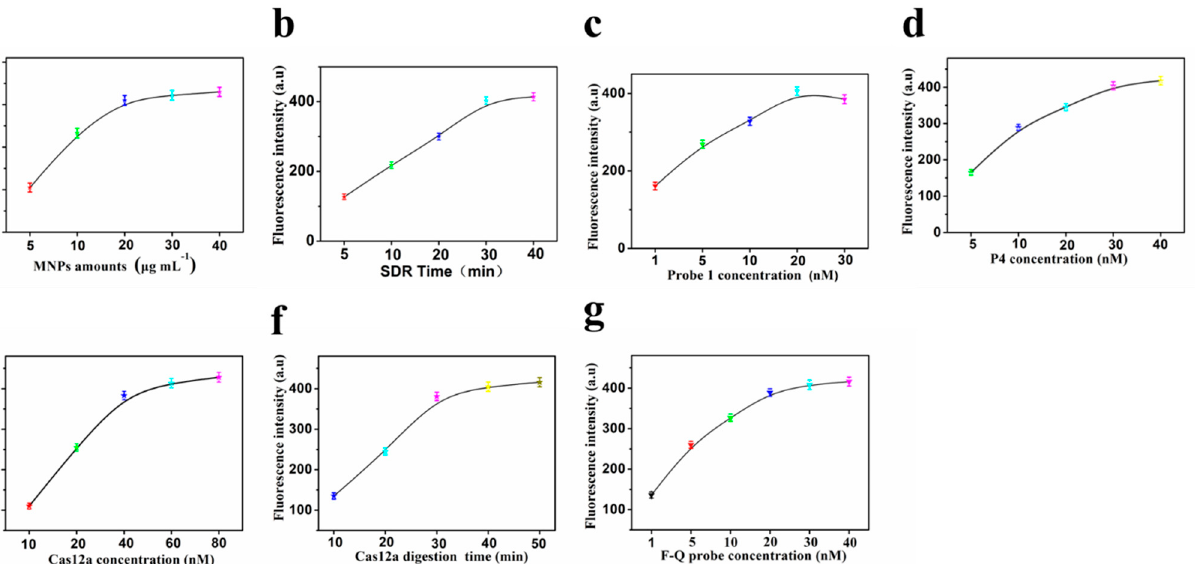
6 of 11 Figure 3. Characterization of exosomes: ( a ) TEM image of exosomes; ( b ) NTA analysis of exosomes. 3.3. Optimization of the Assay Conditions To obtain optimal determination performance, the experimental conditions of the flu- orescent biosensor were optimized by controlling the following parameters: (a) concen- tration of MNPs; (b) reaction time of CSDR; (c) concentration of P1; (d) concentration of